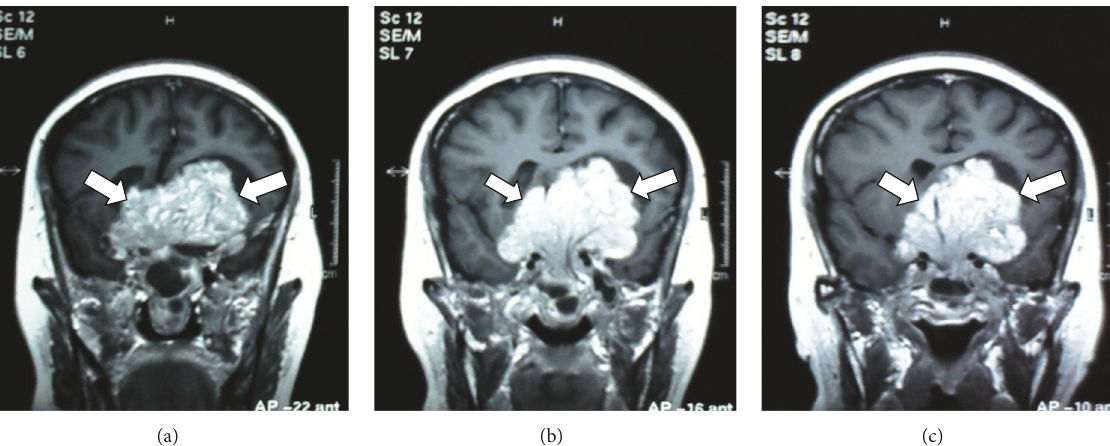
Figure 1: Initial contrast enhanced coronal T1-weighted sequence on MRI showing a large lobulated enhancing solid mass in the sellar and suprasellar regions (white arrows). The mass extends into the subfrontal lobes and in between the two frontal horns causing compression of foramen of Monroe. Inferiorly the mass extends to the sphenoid sinus and into the nasal cavity. The mass appears to encase the cavernous sinus and the optic chiasma.